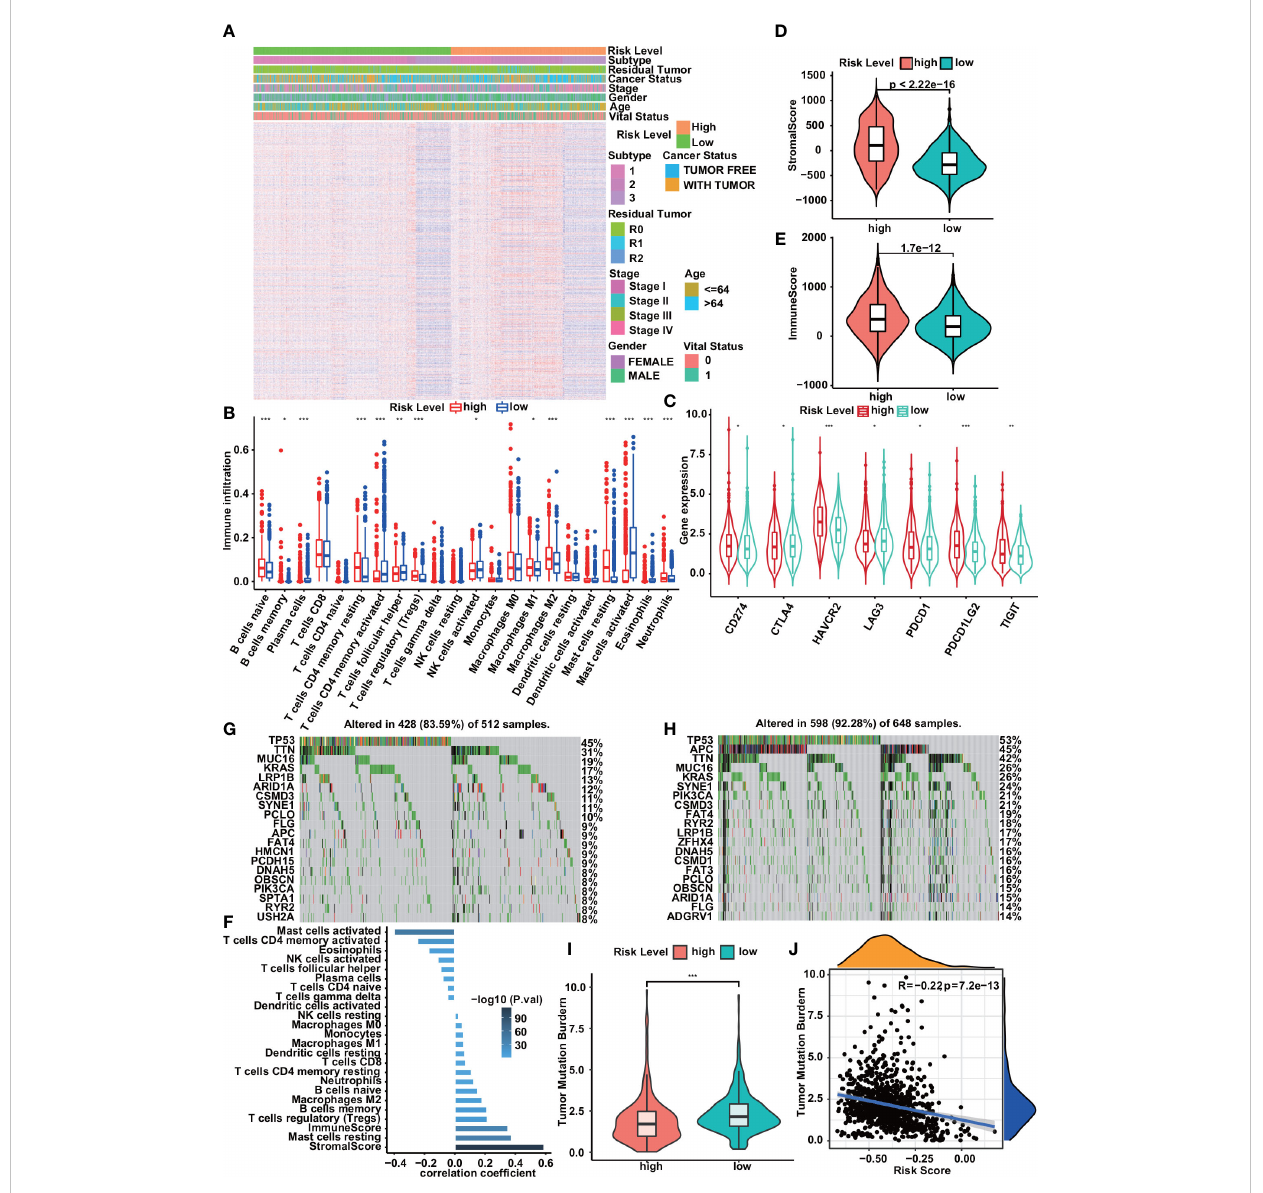
FIGURE 5 Correlation of risk prediction model with immune cell in fi ltration,immune checkpoints, and somatic mutation. (A) Heatmap of immune gene set enrichment scores for high- and low-risk groups. (B) Immune cell in fi ltration in low- and high-risk groups. (C) Compared with the low-risk group, the expression levels of immune checkpoint molecules in the high-risk group were signi fi cantly increased. (D, E) Violin plots show signi fi cant associations between risk group and stromal score (D) , immune score (E) . (F) Correlation between risk score and in fi ltrating immune cell density and stromal/immune score. (G, H) Somatic mutation pro fi les of the 20 most frequently mutated genes in low- and high-risk groups. (I, J) Correlations of risk scores with TMB. The violin plot showed that the low-risk group had higher TMB than the high-risk group (I) . TMB was signi fi cantly negatively correlated with risk score (J) . Statistical signi fi cance was set at P<0.05, shown as *P<0.05,**P<0.01,